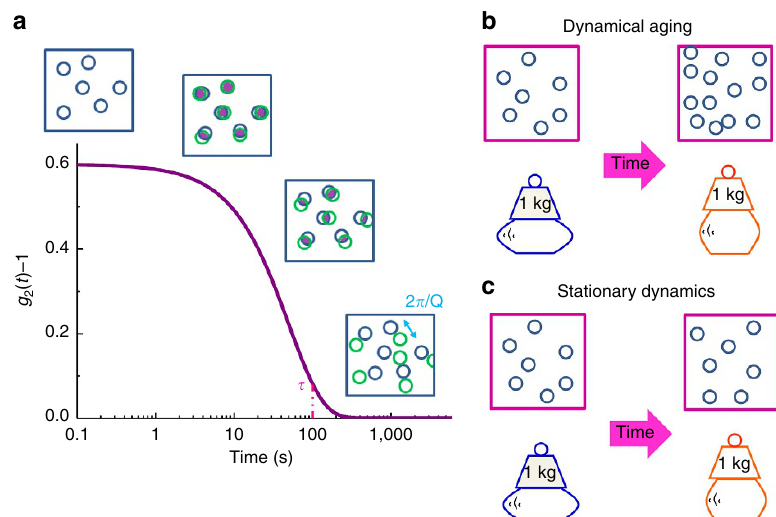
Figure 6 | Sketch of the results. ( a ) Behaviour of a correlation function measured with XPCS; evolution of the structure and the macroscopic properties during the dynamical ( b ) and stationary ( c ) aging regimes measured with XPCS. Explanation in the